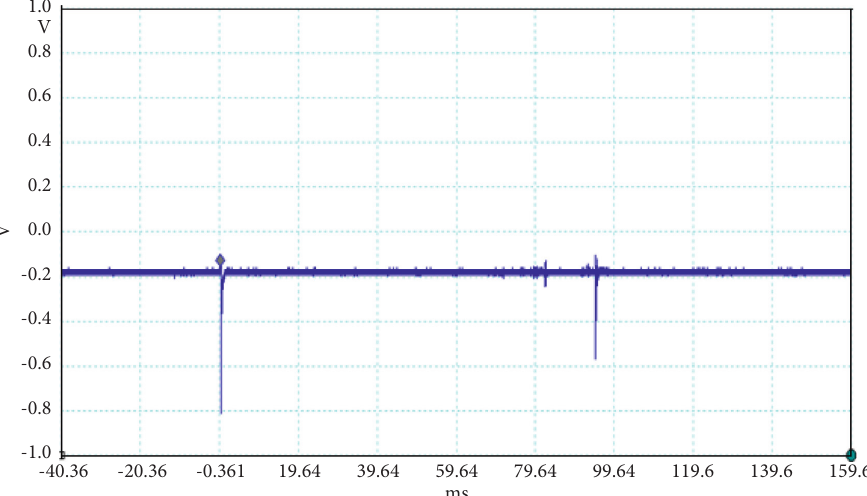
Figure 6: Example of the unusual lightning signal of window size 200ms, which is recorded as a flash number 20150416-0070 in Kathmandu,